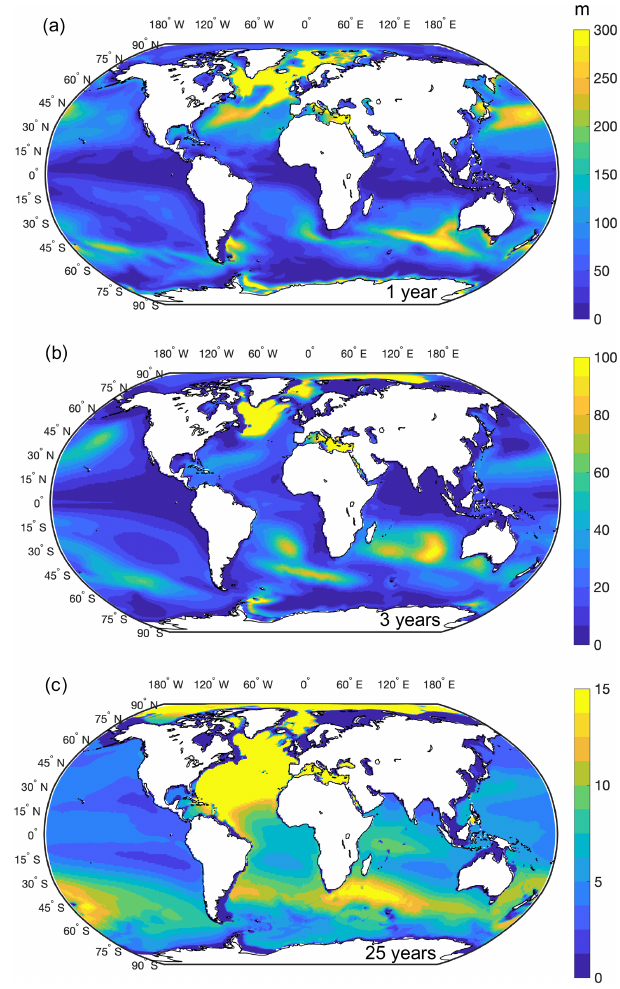
Figure 7. Ventilation thickness 1 year (a) , 3 years (b) , and 25 years (c) after the dye injection for one of the